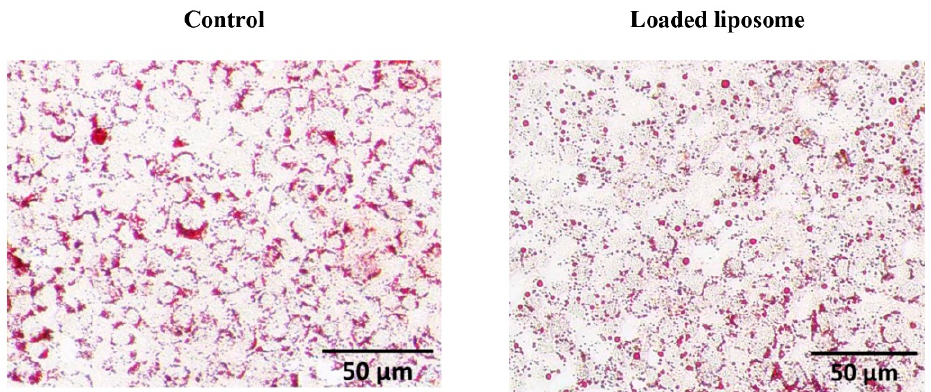
Figure 3. Lipolysis effects of the loaded liposome on the differentiated adipocyte cells. The ORO lipid staining of 3T3-L1 adipocytes was observed using a stereomicroscope at 5× magnification. The cells with no treatment were used as a control (Control).